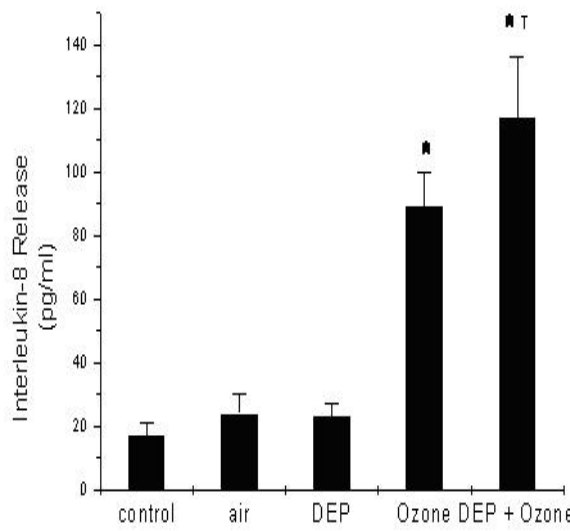
Figure 3: Effect of Exposure to DEP alone, Ozone, or DEP Following Ozone on IL-8 Release in A549 Cells.